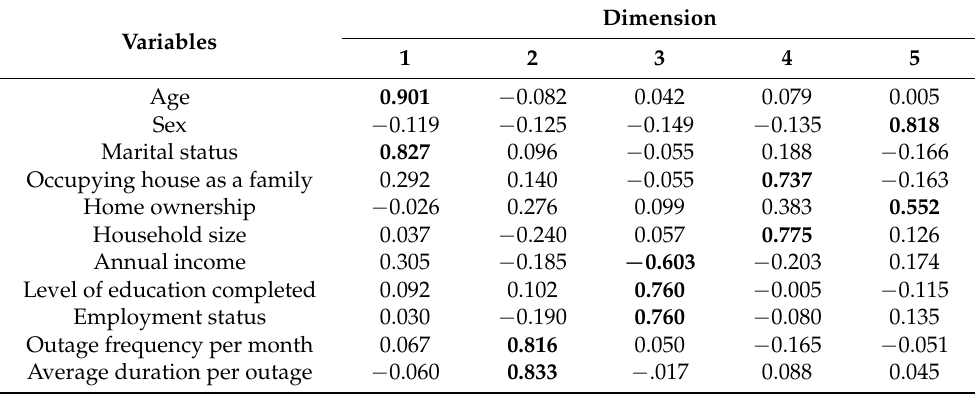
Table 7. Matrix of rotated component loadings.